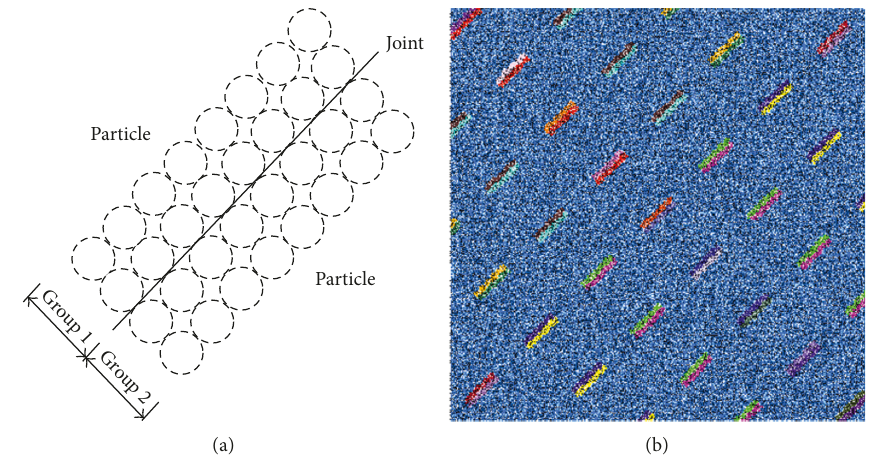
Figure 22: Particle grouping technique.